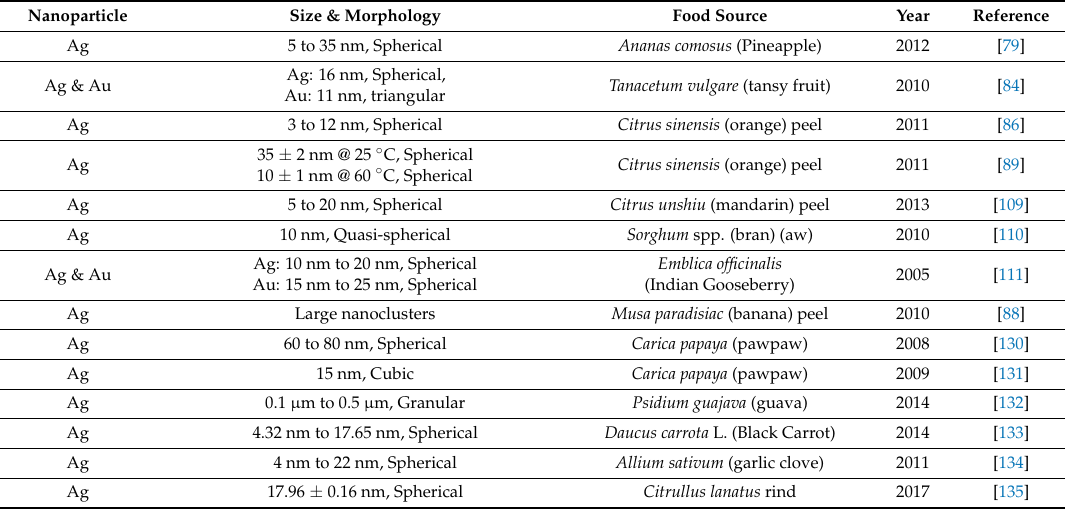
Table 1. A selection of nanoparticles biosynthesised by horticultural waste